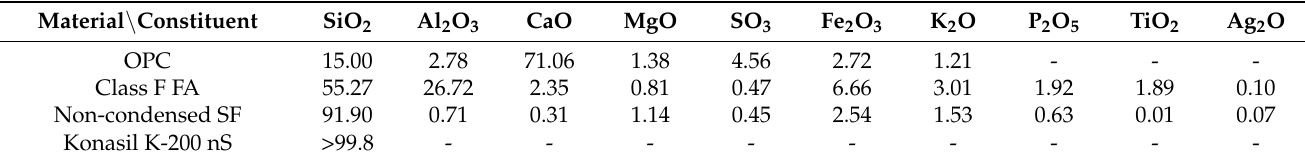
Table 2. Chemical composition of the binders used (mass